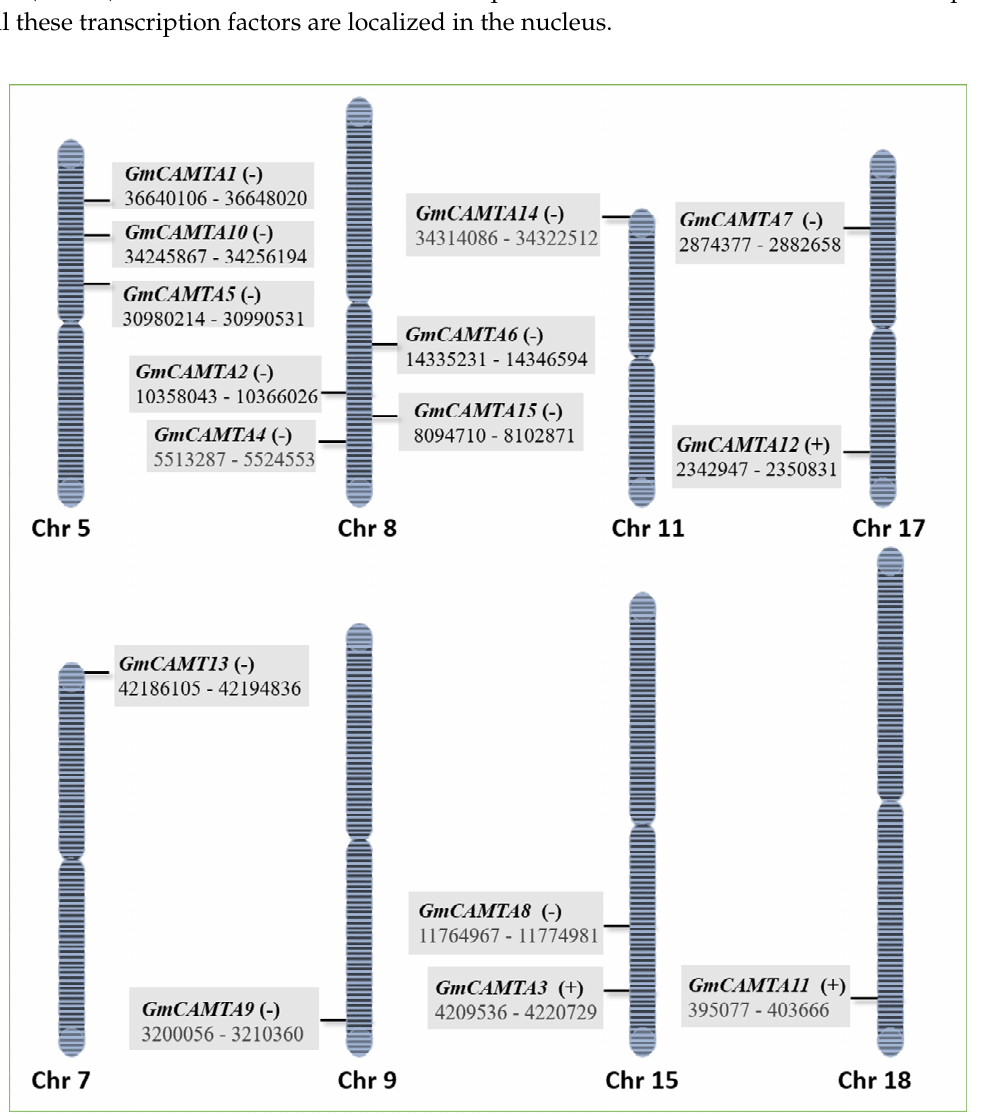
Figure 2. Chromosomal distribution of GmCAMTA genes. The 15 GmCAMTA genes are located on chromosome 5, 7, 8, 9, 15, 17 and 18.